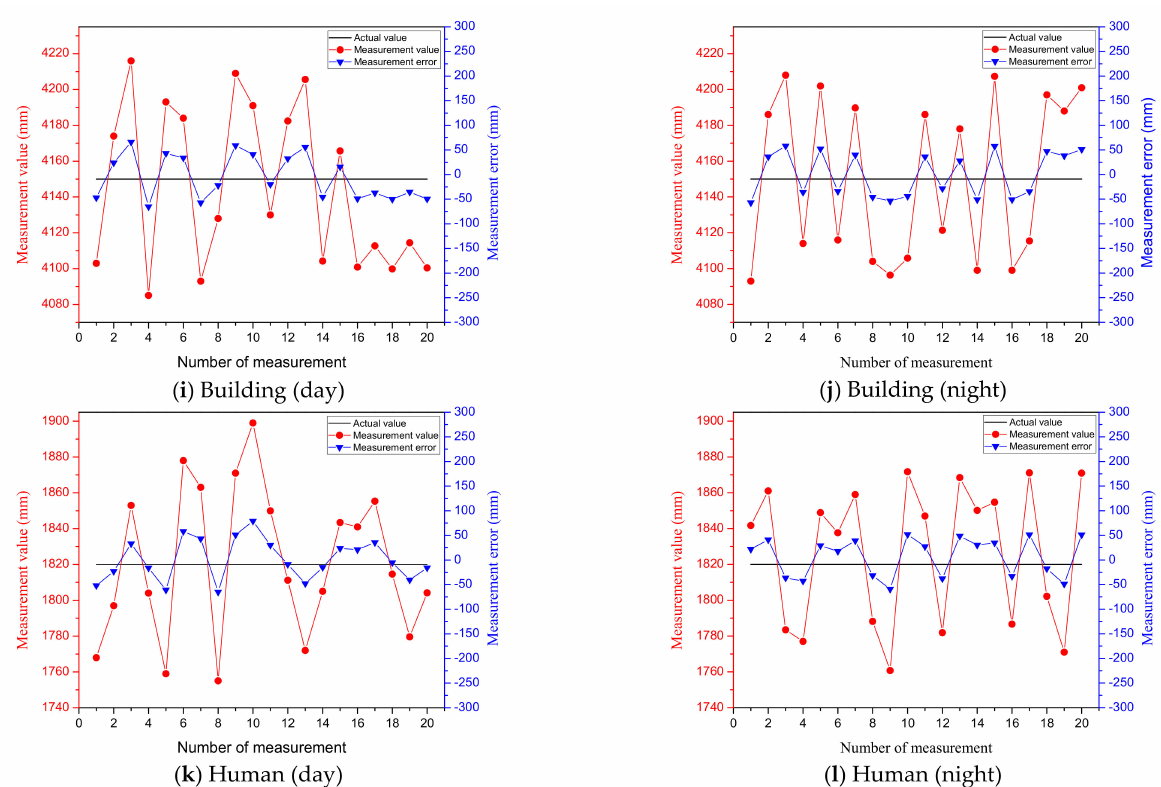
Figure 10. Actual value, measurement value and measurement error chart when measuring different objects.